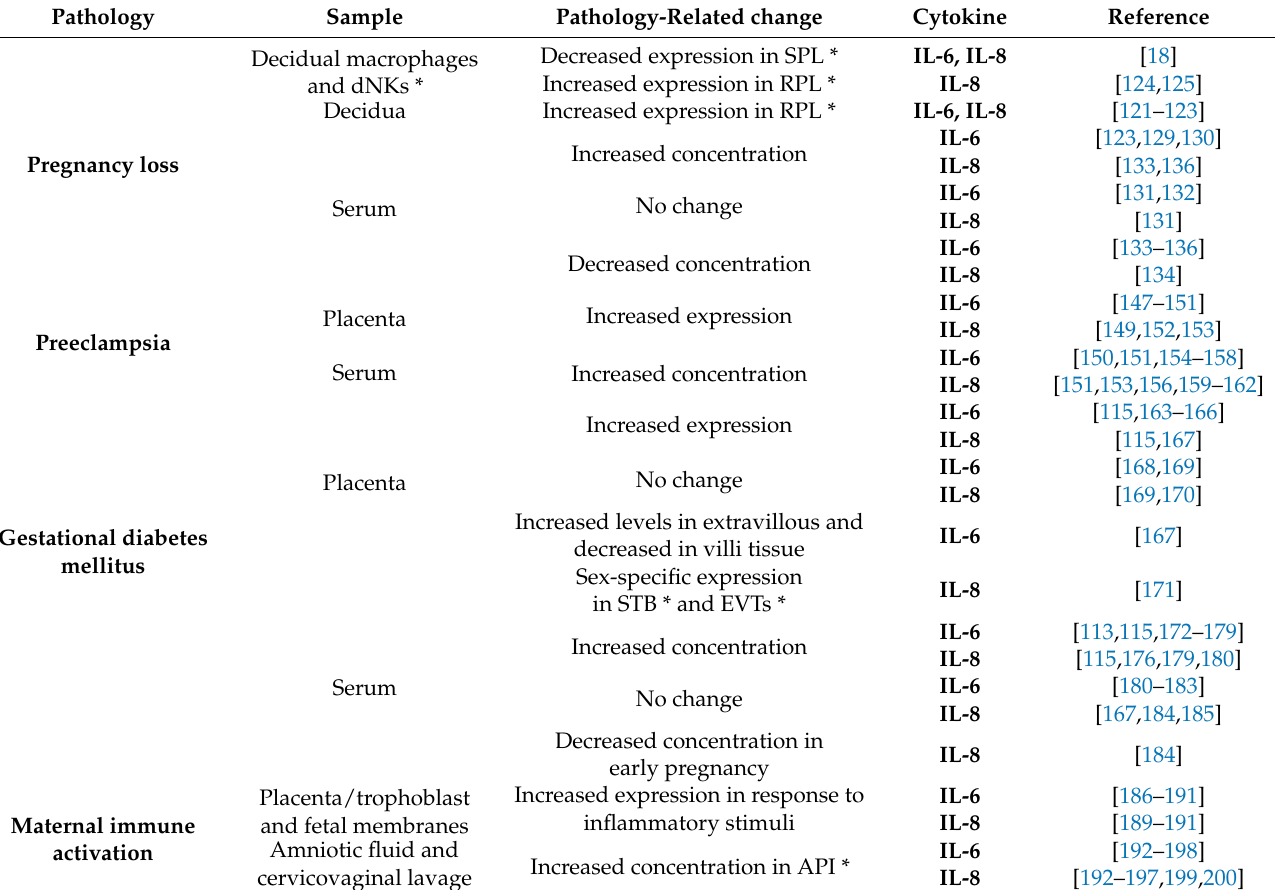
Table 2. Pathology-related changes of the IL-6/IL-8 in pregnancy